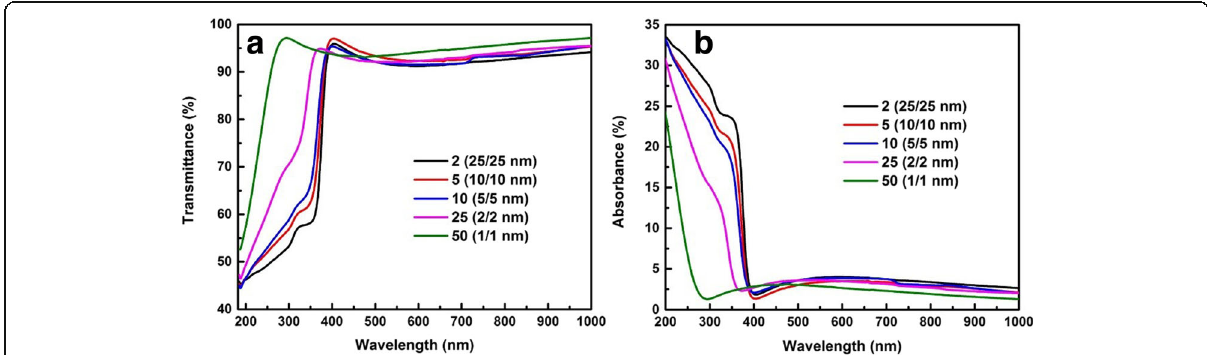
Fig. 8 a Transmittance and b absorbance spectra of nanolaminates grown on quartz substrates with different bilayer thicknesses